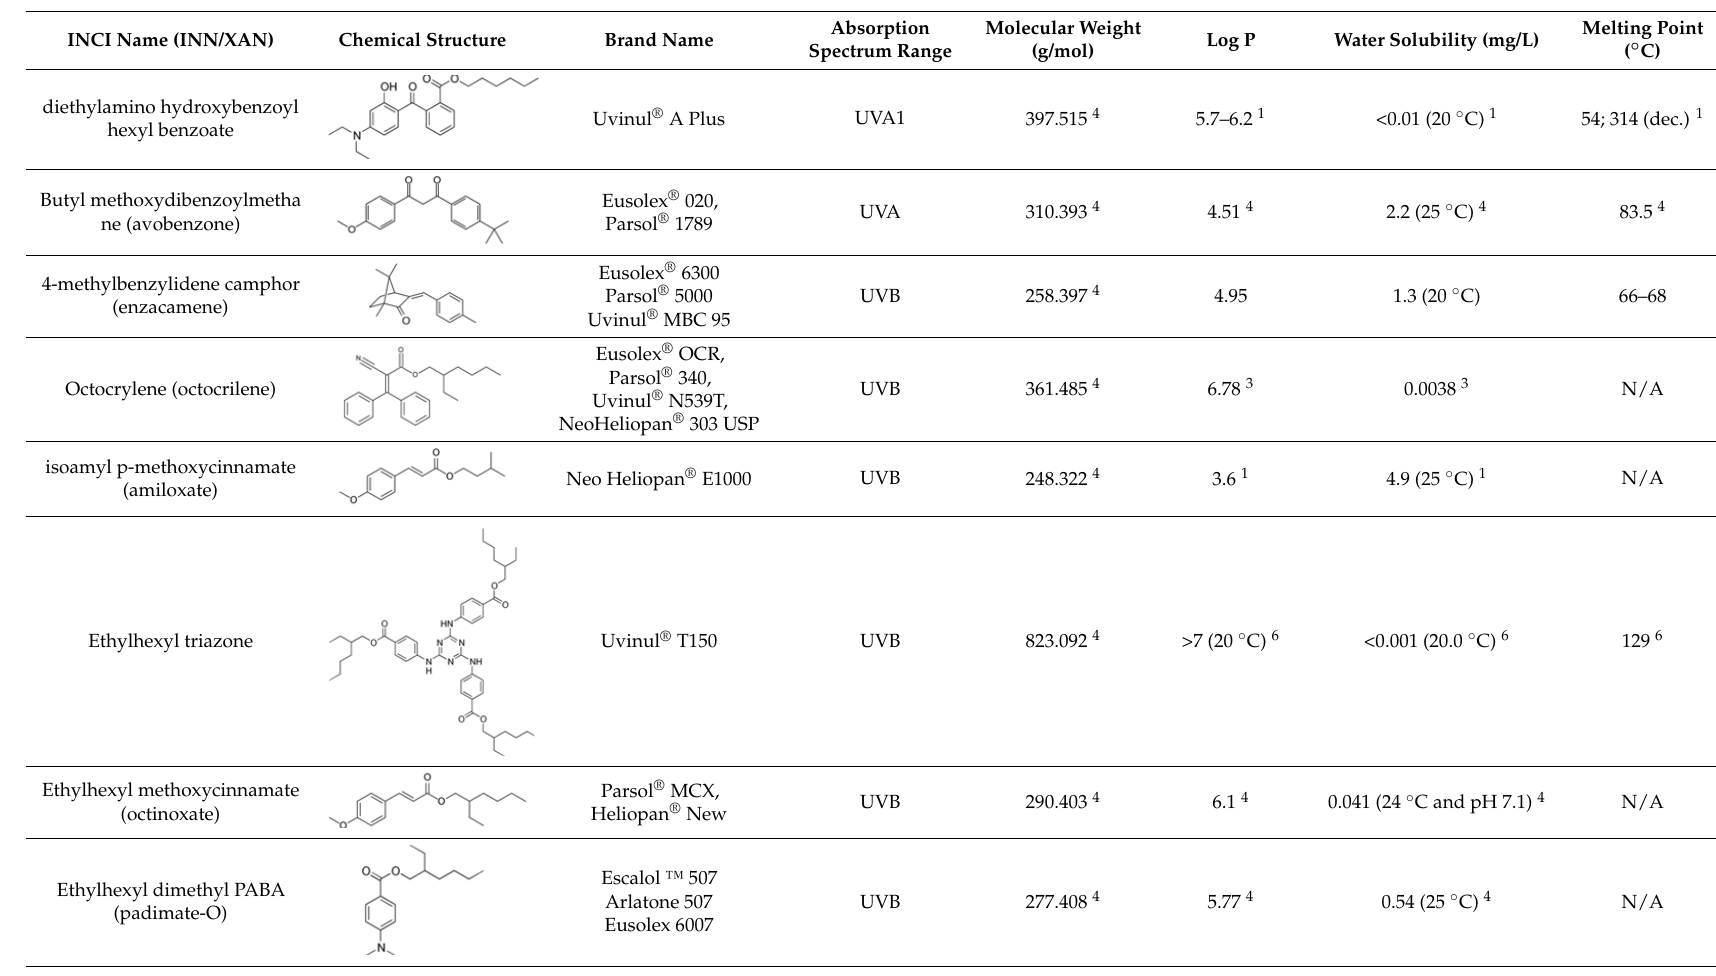
Table 1. Experimental and predicted physical-chemical parameters of the most recently investigated UV-absorbers.